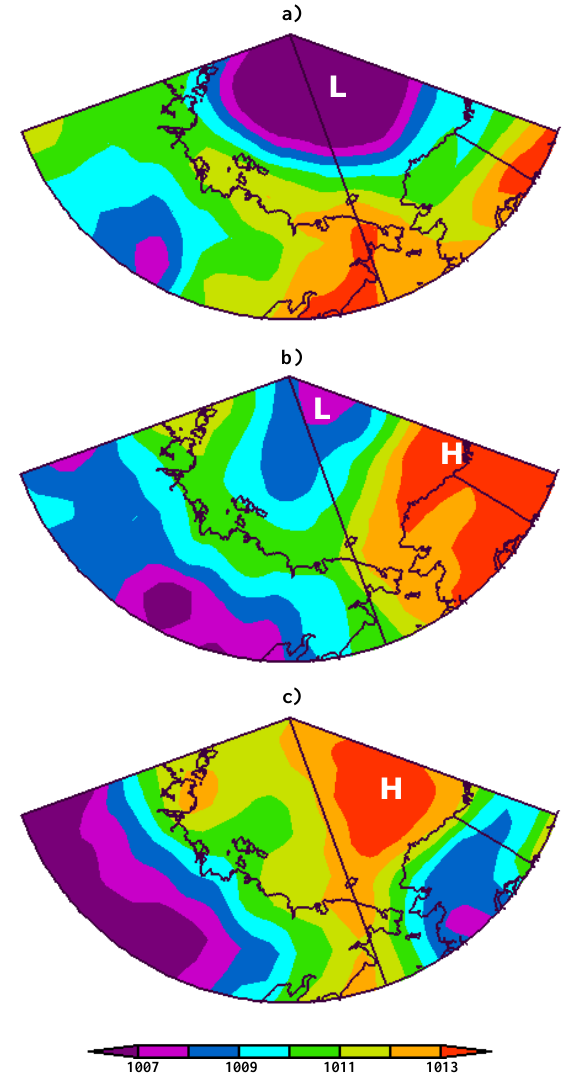
Fig. 3. Sea level pressure fields (mbar), averaged over the summer season (July–September) in 2003 (a) , 2004 (b) , and 2008 (c) , from NCEP